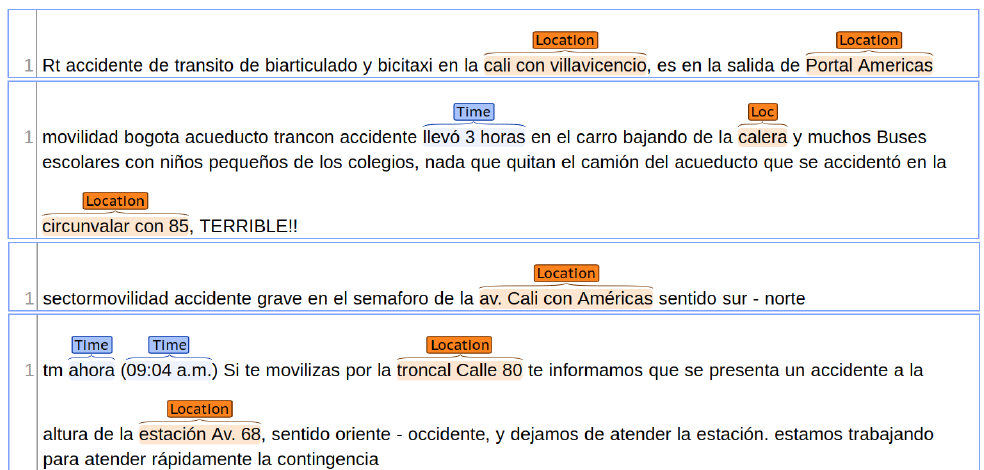
Figure 2. Manual labeling using Brat Annotation